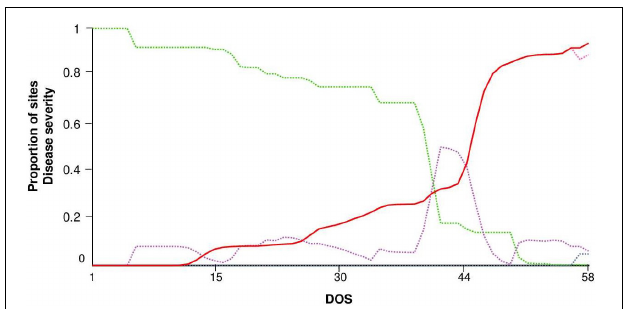
FIGURE 4 | Model output for the experimental field in Rosemount, MN, United States, in 1968 (ROS68). Dynamics of sites: healthy (H, green dotted line), latent (L, purple dotted line), infectious (I, pink dotted line), removed (R, gray dotted line), and disease severity (DS, red solid line). Vertical axis: proportion of sites on a 0 to 1 scale. Horizontal axis: days of simulation (DOS); the model was run from June 5 (i.e., 9 days before the last disease assessment in which no stem rust symptoms were observed, see Table 3 ).